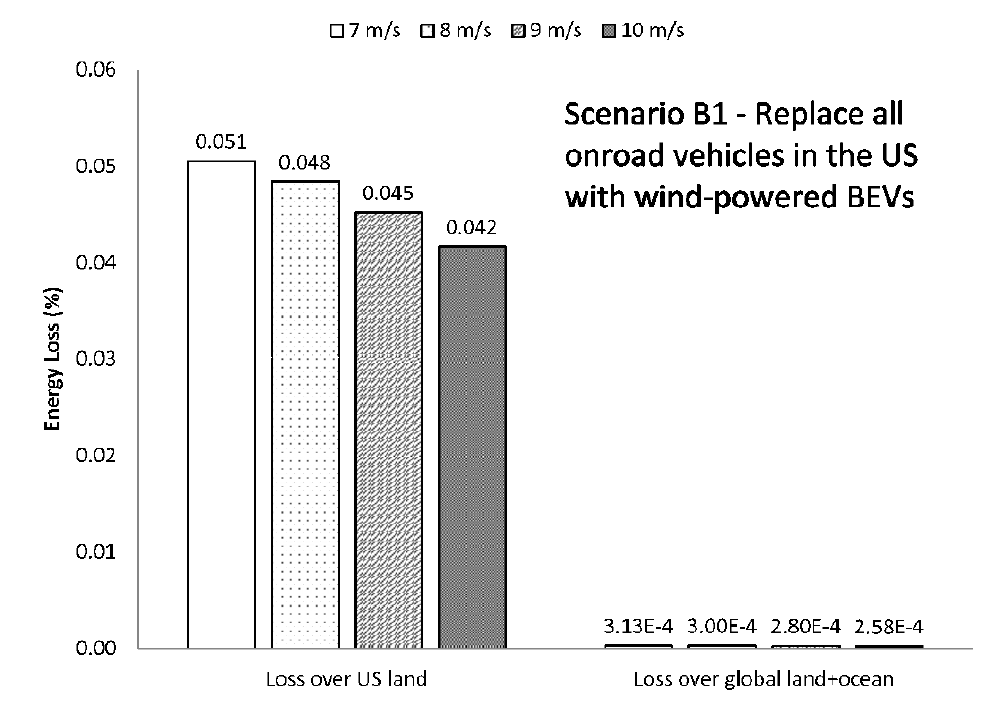
Figure 13. Energy loss (%) for Scenario B1, where all U.S. onroad vehicles are replaced with WBEV. The number of turbines for each mean wind speed case is given in Table